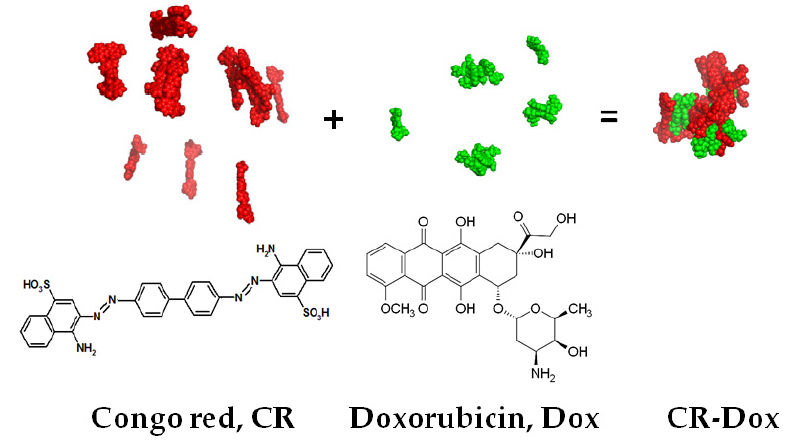
Figure 1. Structure of Congo red and Doxorubicin and the supramolecular complex CR-Dox.